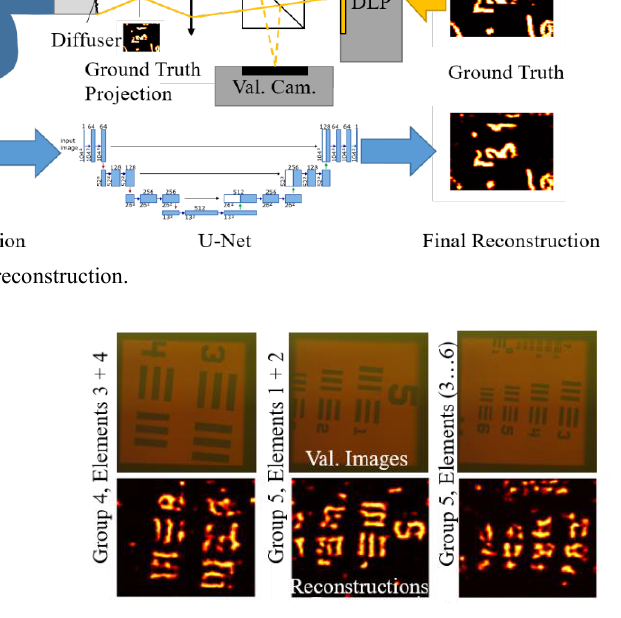
Fig. 3. Reconstruction (bottom) of a physical USAF target and validation images (top).